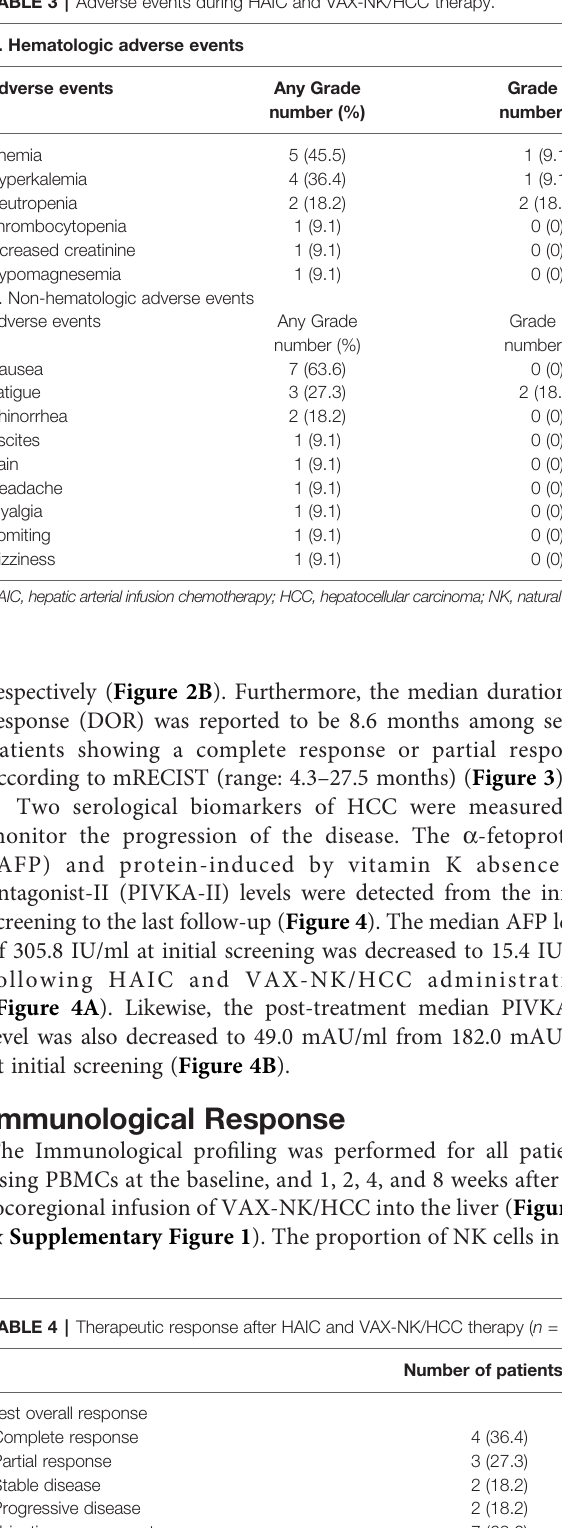
TABLE 3 | Adverse events during HAIC and VAX-NK/HCC